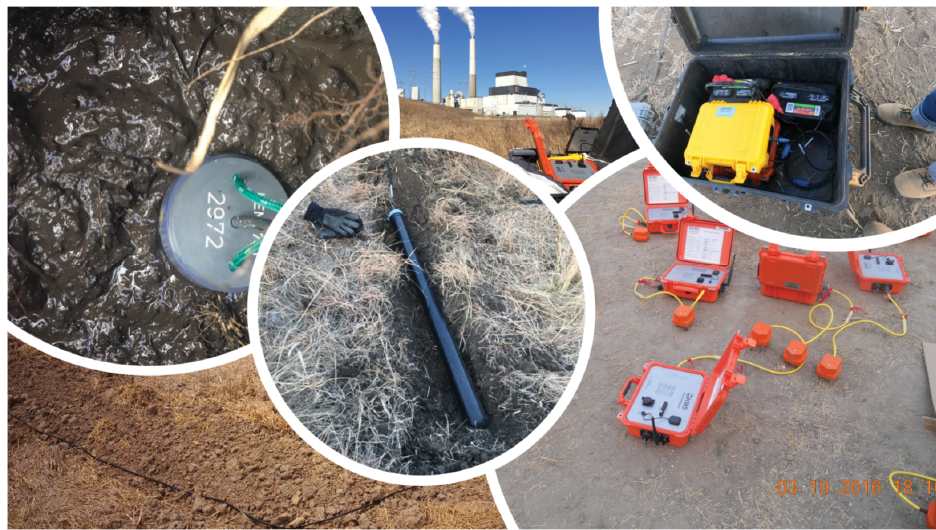
Figure 8. Pictures of the various electromagnetic sensors and acquisition systems in field settings. At the top left is an electrode used for the electric field measurements. At the top center is the acquisition system near a power plant followed on the top right followed by a closer view of the system, web access box, and battery in a field container. Below on the bottom right are several systems during a test with seismic 3-component geophones connected. In the center is a magnetic field sensor (induction coil) and in the bottom left a magnetic field sensor implemented by a large multi-turn air loop.